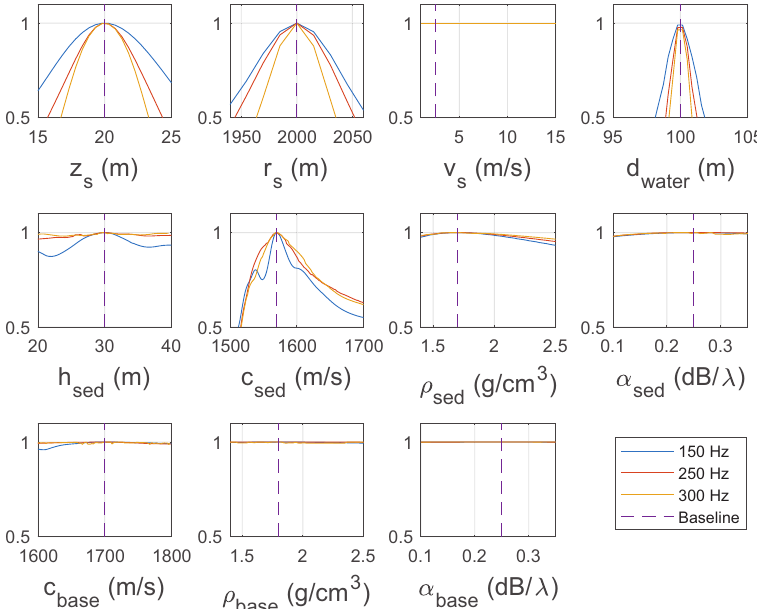
Figure 2. Sensitivity analysis for different geoacoustic parameters in the simulation environment at k =